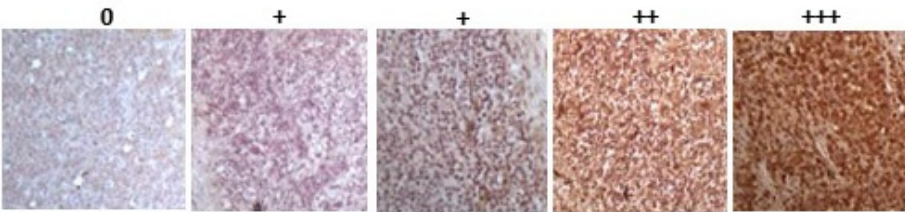
Figure 1. Scoring range/index (0, +, ++, +++) for immunohistochemical detection intensity of PADs, total deiminated proteins (F95) and histone H3 deimination (CitH3), as indicated for the different samples in Table 1. Table 1. Scoring for immunohistochemical staining results of the different histological tumour samples assessed in the current study. Staining intensity for each antibody, in each tumour sample, is based on the representative scoring index shown in Figure 1. Immunohistochemical staining results for each tumour sample assessed are shown for: pan-deimination staining using the F95 antibody, deiminated histone H3 (CitH3), and PAD isozymes 1–6. Animal species, tumour type, and staining intensity are listed. Tumour F95 CitH3 PAD1 PAD2 PAD3 PAD4 PAD6